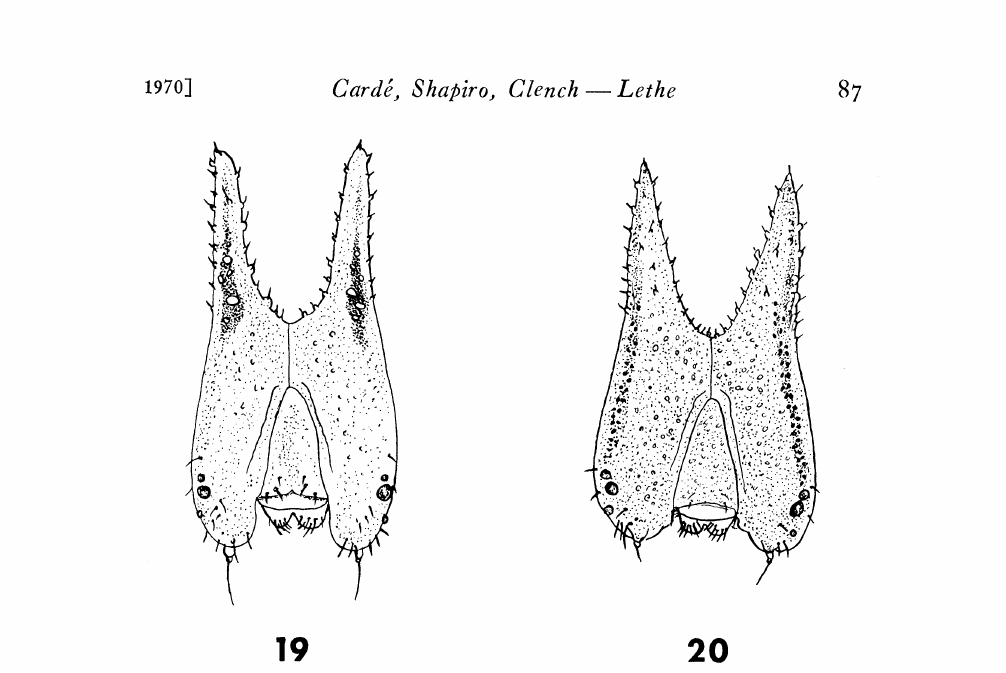
Fig. 19. Larval head capsule of Lethe appalachia. Fig. 20. Larval head capsule of Lethe eurydice